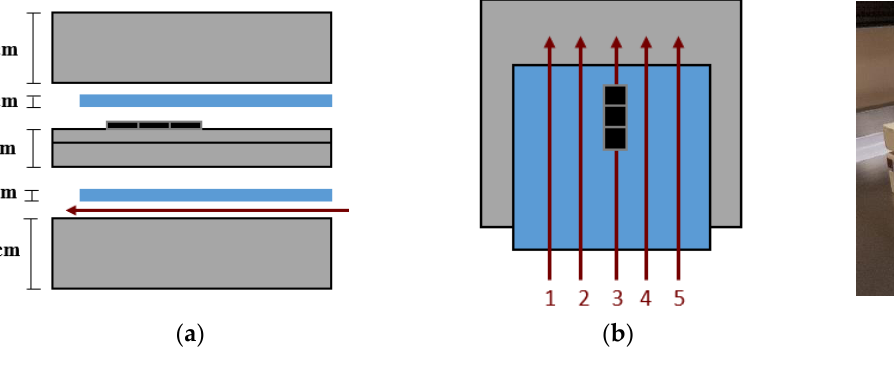
Table 1. Calibration levels. Dose levels used to build each calibration curve.